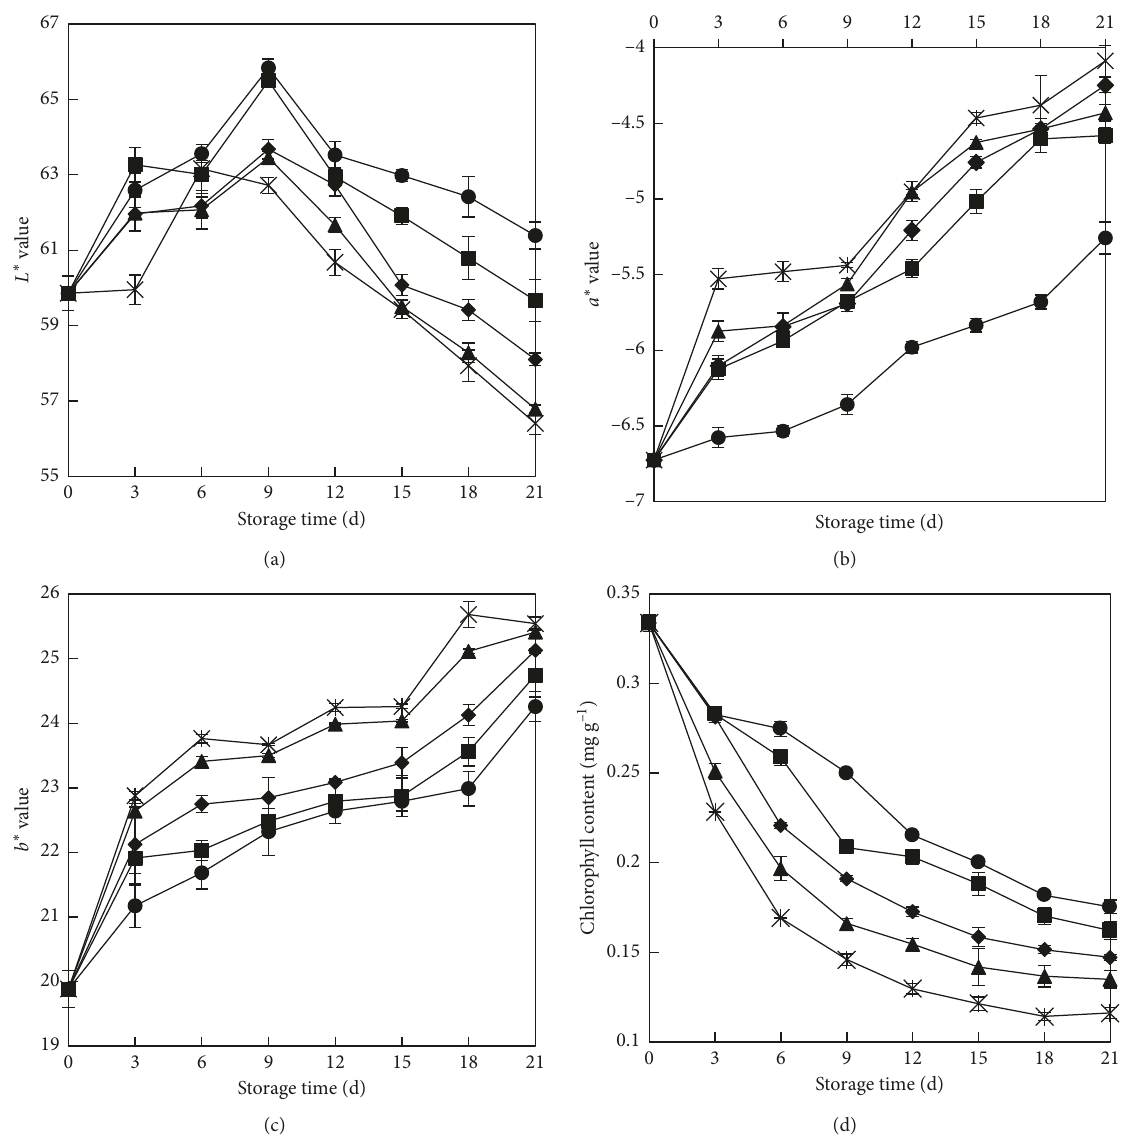
Figure 1: Effects of 1-MCP treatment on L ∗ (a), a ∗ (b), b ∗ (c) values, and chlorophyll content (d) of yardlong bean during storage at 8 ° C. Each data point is the average of nine pods. Error bars represent the standard error of the means. Control ( ✲ ), 0.75 μ L · L − 1 ( ■ ), 1.0 μ L · L − 1 ( •